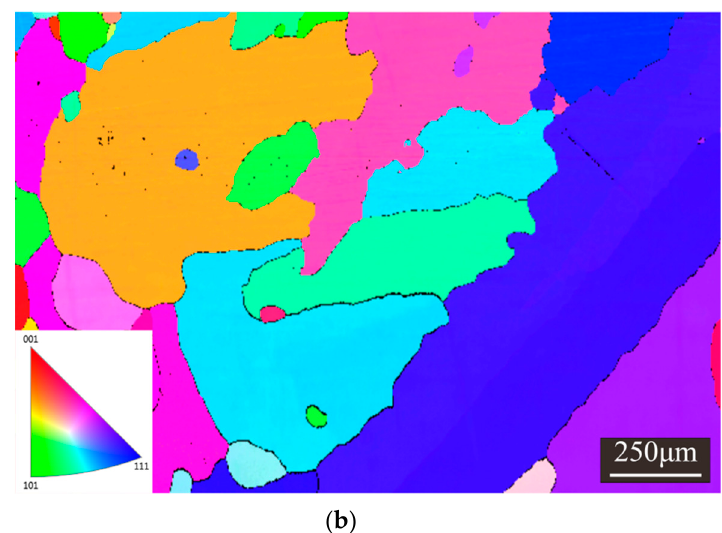
Figure 9. EBSD of polished longitudinal-sections of the NbMoTa HEAs. ( a ) Laser cladding deposition (LCD), ( b ) vacuum arc melting (VAM).